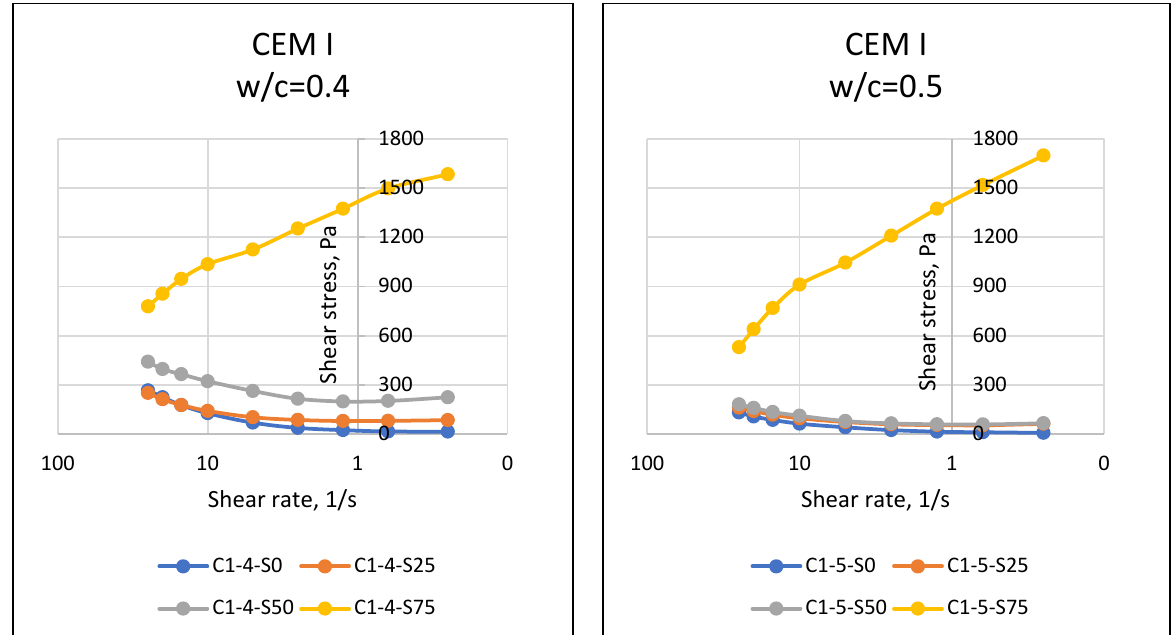
Figure 5. Shear Stress–Shear Rate Relationships of SAPCPs with CEM I (w/c = 0.40 and 0.50).